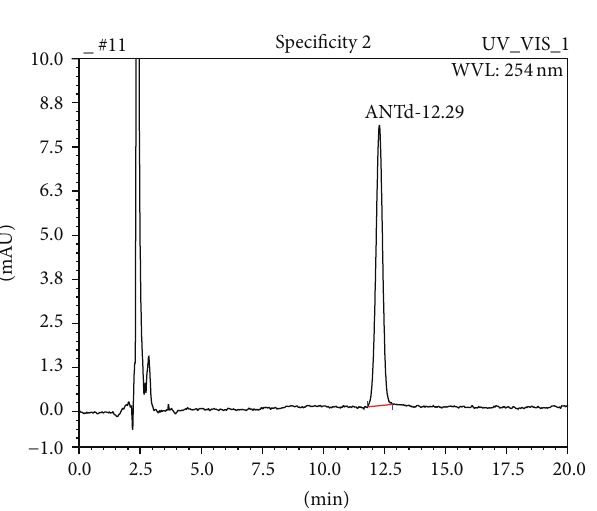
Figure 4: Extract of a pure Alpha Swab.